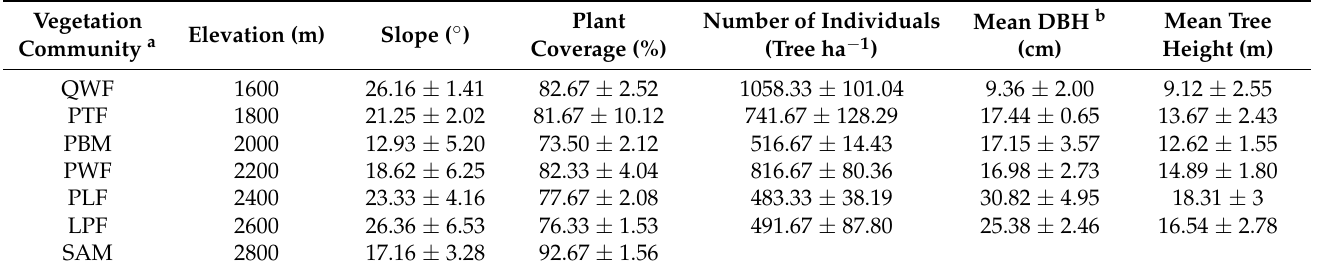
Table 1. Stand characteristics of seven typical vegetation community ecosystems along the altitude gradient in the Guandi